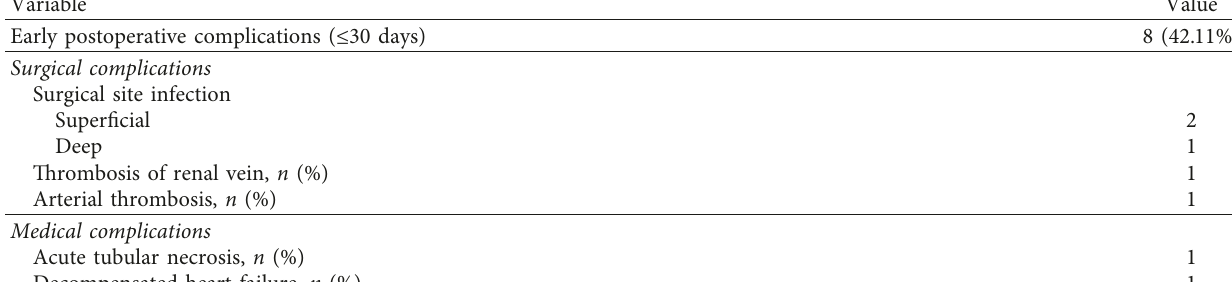
Table 8: Early and late postoperative complications of KAT.